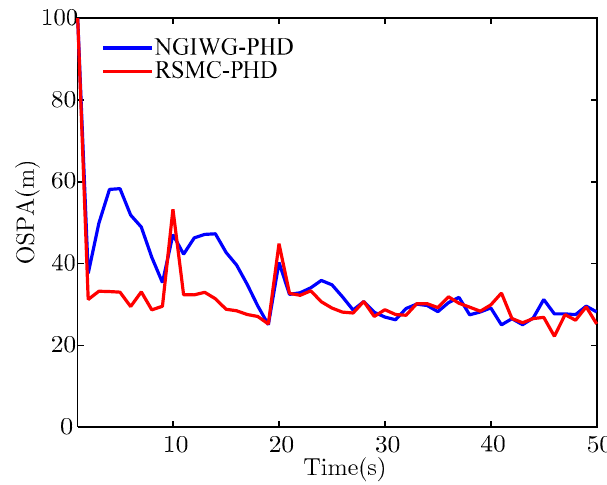
Figure 11. The estimate of OSPA.